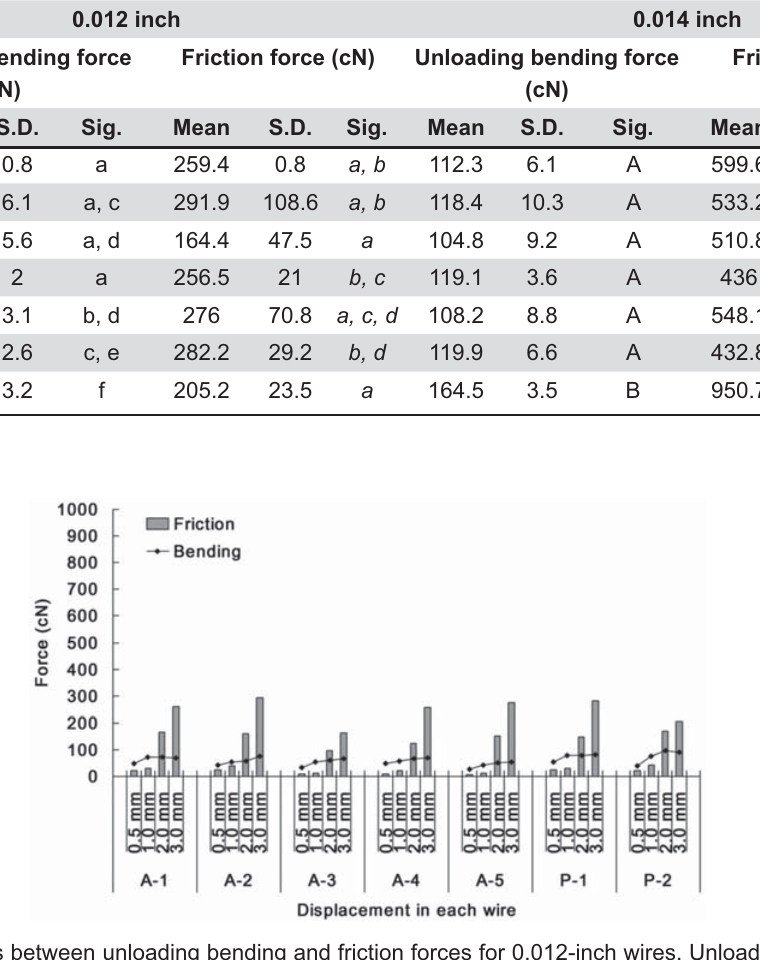
Table 4- Unloading bending and friction forces at a displacement of 3.0